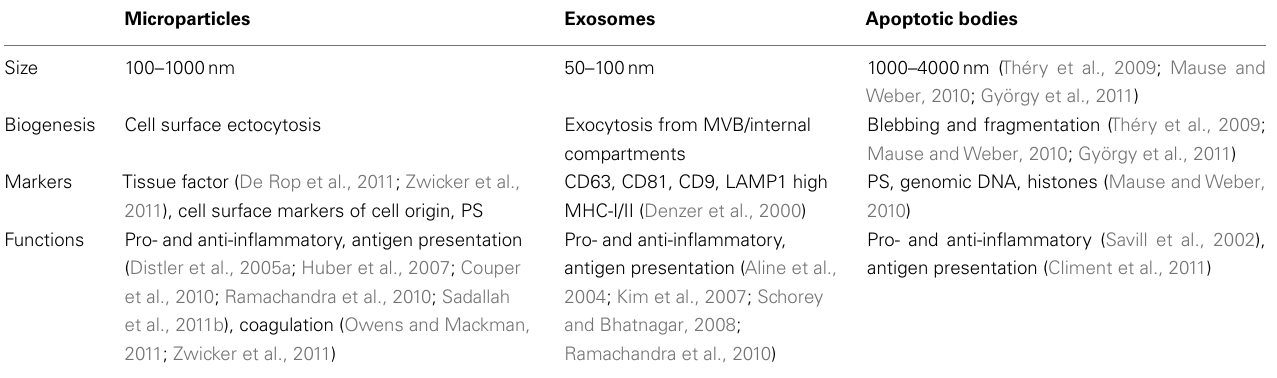
Table 1 | Comparison between microparticles, exosomes, and apoptotic